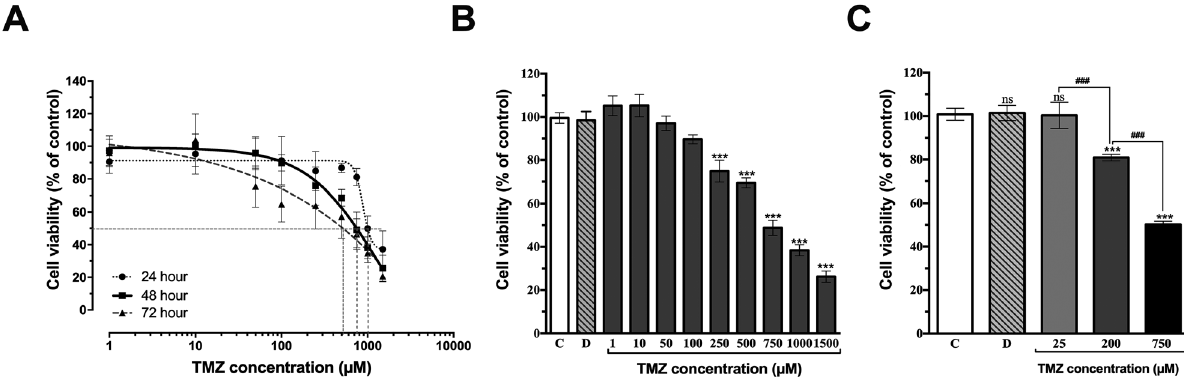
Figure 1: Effect of temozolomide (TMZ) on the viability of U87MG cells. A) Cell viability was determined by MTT assay. The dose-dependent curveofTMZonU87MGcellviabilityfor24,48,and72h.IC 50 valuefor48his748.27 μ M( R 2